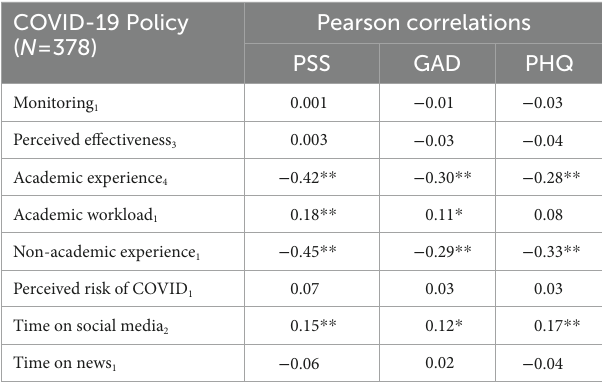
TABLE 3 Mental health and COVID-19 policies Spring